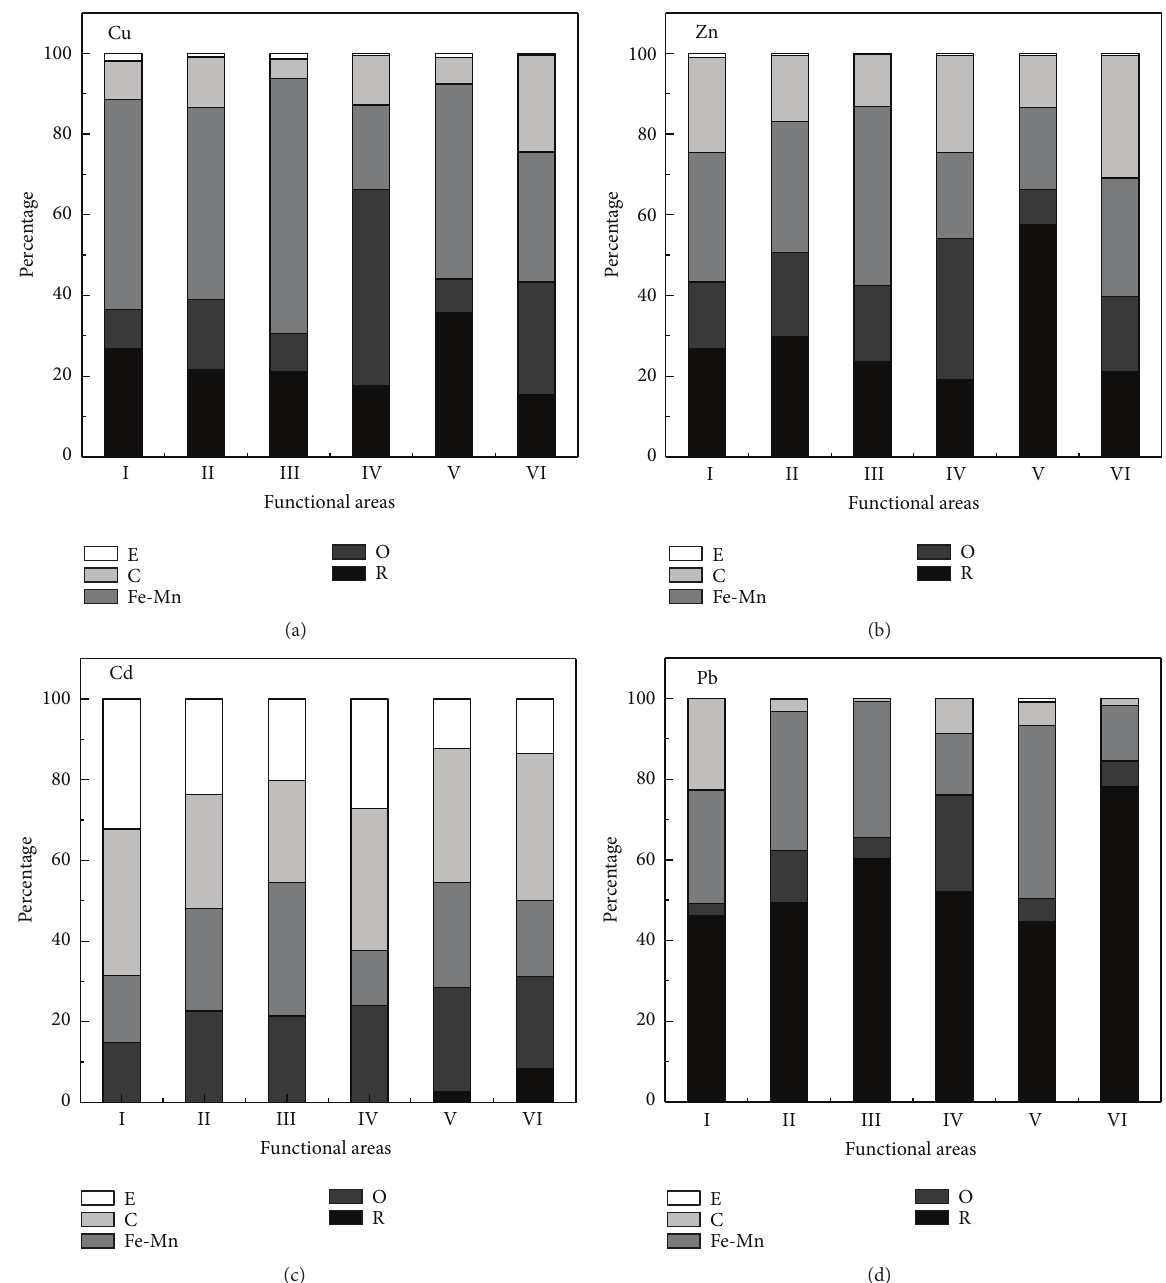
Figure 3: The fractionation distribution of metals Cu, Zn, Cd, and Pb in six functional areas: (I) old residential area, (II) comprehensive area, (III) new residential area, (IV) pedestrian only commercial area, (V) educational area, and (VI) business area. Note: E, C, Fe-Mn, O, and R represent exchangeable fraction, carbonate bound fraction, Fe-Mn oxide bound fraction, organically bound fraction, and residual fraction,